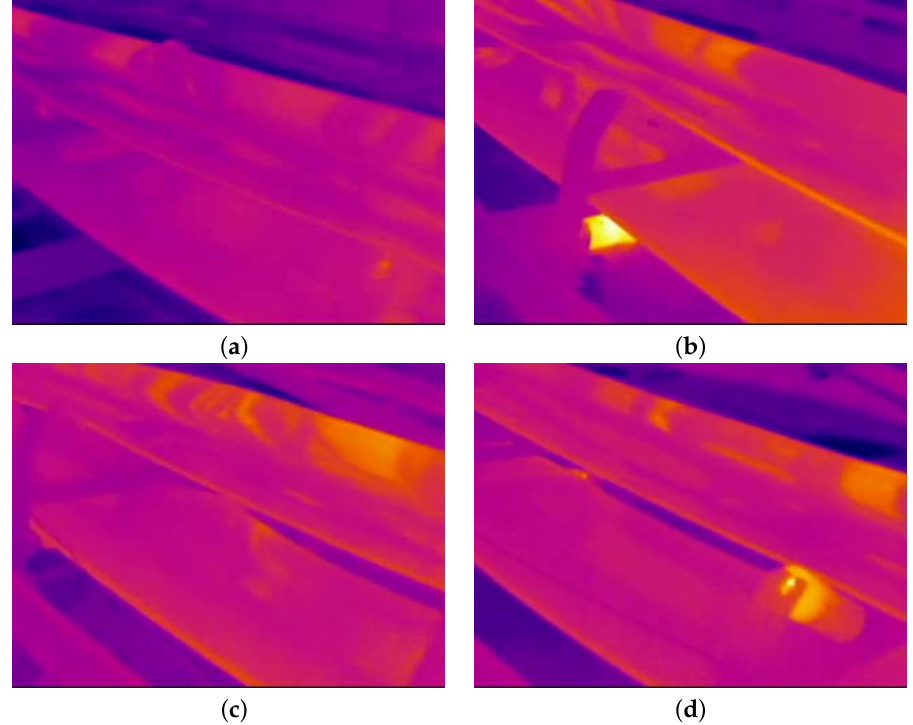
Figure 9. Four classes of images that were difficult to analyze. ( a ) Image without hot idler, ( b ) Image with hot idler, ( c ) Image with sunlight reflections, ( d ) Image with sunlight reflections and a hot idler.